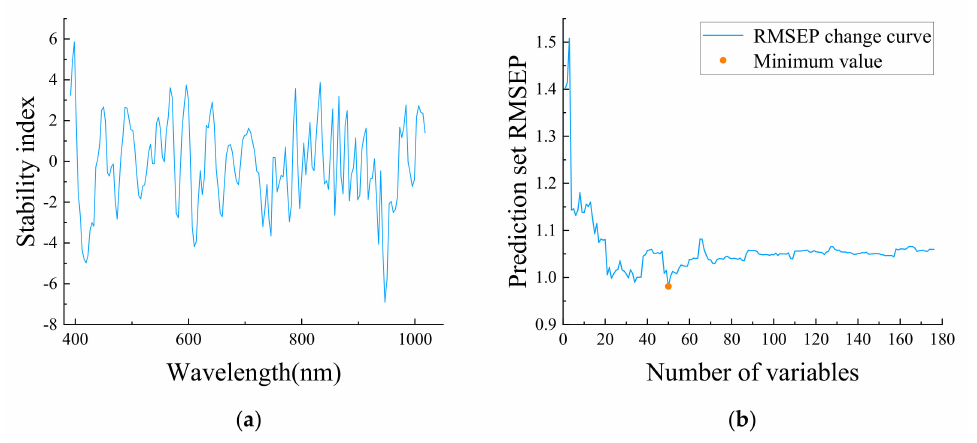
Figure 12. MCUVE wavelength screening process. ( a ) Stability of correlation coefficient for each wavelength. ( b ) Variation with number of variables prediction set RMSEP.